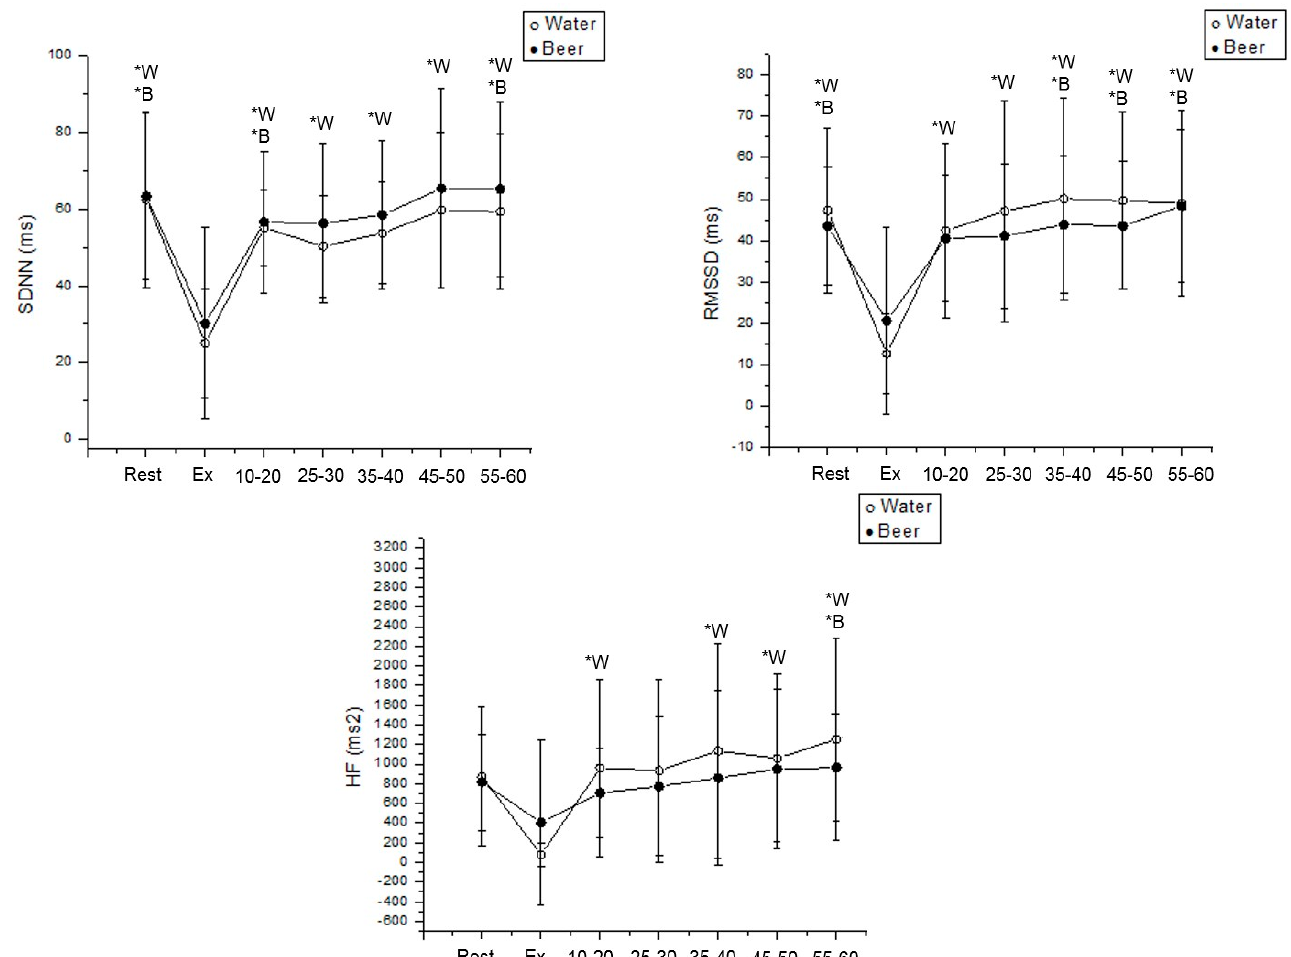
Figure 5. SDNN, RMSSD and HF values were obtained at rest and during recovery from moderate aerobic exercise protocol in men. *W: Values with significant differences in relation to exercise ( p < 0.01) for water protocol; *B: Values with significant differences in relation to exercise ( p < 0.01) for beer protocol.